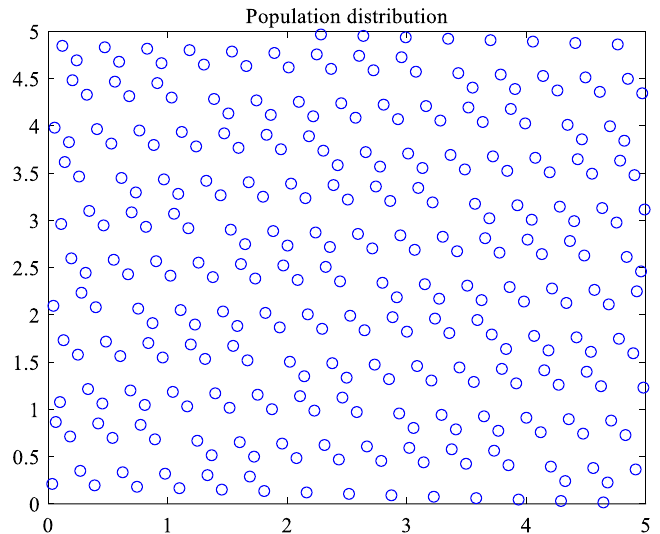
Figure 2. Good point set initialization.